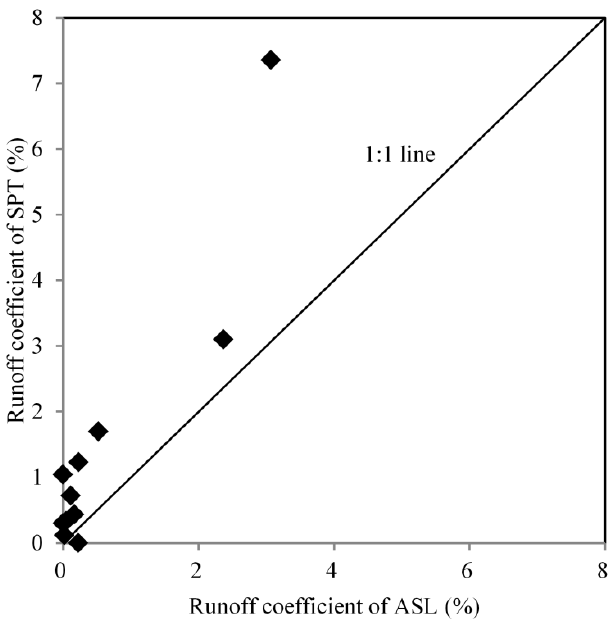
Figure 6. Difference of runoff coefficients between the SPT site and the ASL site. Figure 6. Di ff erence of runo ff coe ffi cients between the SPT site and the ASL